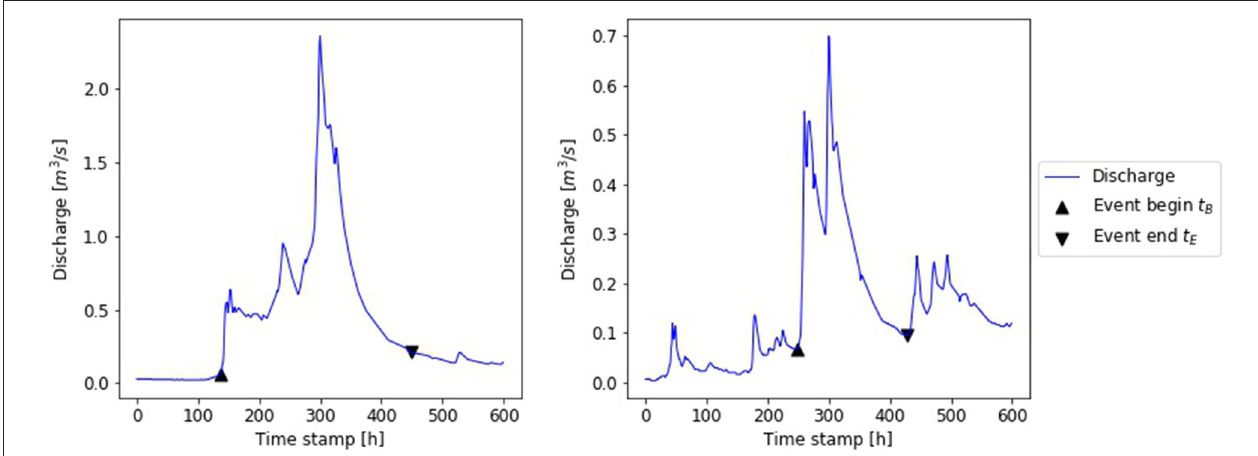
FIGURE 1 | Flood events observed at gauge Friedersdorf with manual defined markers of event begin t B and end t E to capture direct